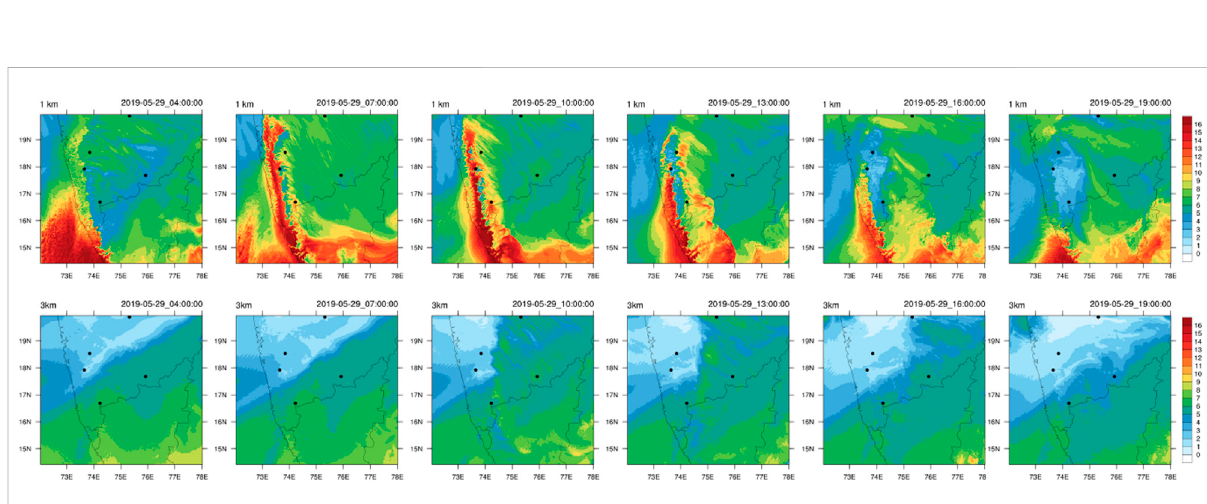
FIGURE 4 Diurnal cycle (0700 – 1900 UTC) of the spatial distribution of moisture from WRF model on 29 May 2019 at 1 km and 3 km altitude levels.